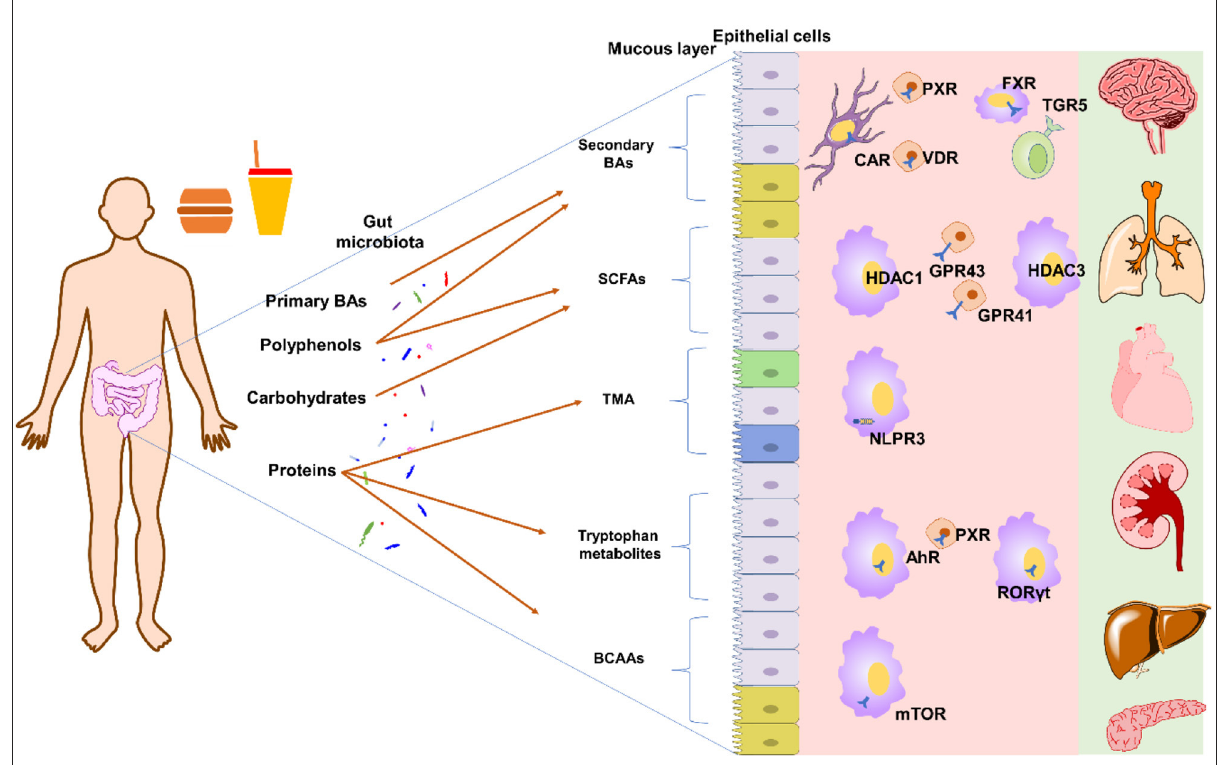
FIGURE1 Typical gut microbiota derived metabolites and their targets. Primary BAs can by transformed into secondary BAs by bile salt hydrolase and 7 α -dehydroxylase[[Inline Image]]. Polyphenols can modulate the composition of gut microbiota to affect SCFAs production or be directed degraded into SCFAs. Polyphenols can also affect 7 α -dehydroxylase activity to influence BA pool. Carbohydrates can be directly fermented into SCFAs. Proteins can be degraded into peptides and amino acids, which can further be transformed into TMA, tryptophan metabolites, and others. Please refer to main text for detailed metabolites and targets. AhR, aryl hydrocarbon receptor; BAs, bile acids; BCAAs, branched-chain amino acids; CAR, constitutive androstane receptor; FXR, farnesoid X receptor; GPR41, G protein-coupled receptor 41; GPR43, G protein-coupled receptor 43; HDAC1, histone deacetylase 1; HDAC3, histone deacetylase 3; NLPR3, inflammasome NOD-like receptor protein 3; PXR, pregnane X receptor; ROR γ t, retinoid-related orphan receptor gamma-t; SCFAs, short-chain fatty acids; TMA, trimethylamine; TGR5, Takeda G-protein receptor 5; VDR, vitamin D3